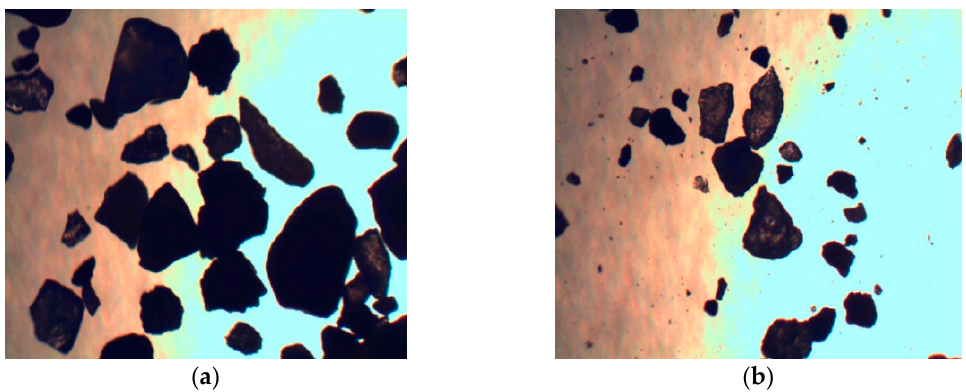
Figure 5. Microscopic view (40×) of Ramsar sand, where ( a , b ) are, respectively, before and after the test.